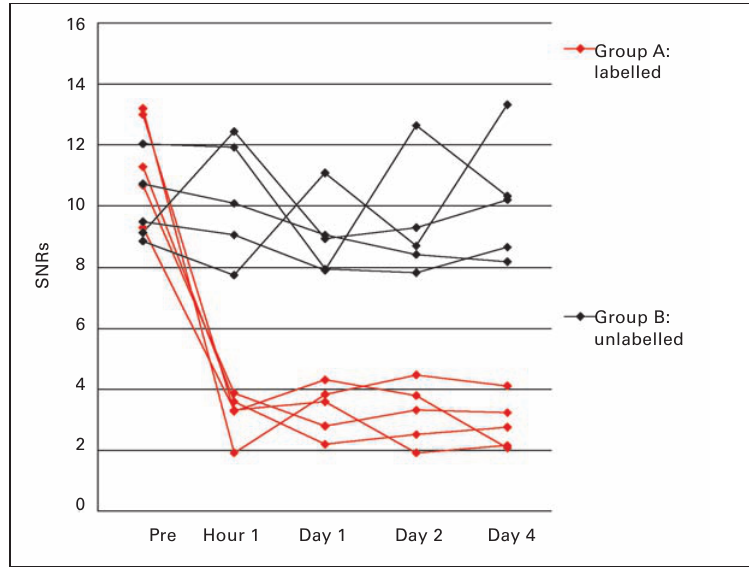
Quantitative measurement of signal-to-noise ratio (SNR)s of outer zone of rats renal cortex on T2*WI at different time points before and after administration of labelled mesenchymal stem cells (MSCs) (group A, red line) and unlabelled MSCs (group B, black line): one line for each rat. In group A, there is significant SNR decrease of renal cortex 1 hour, 1, 2, 4 days after labelled MSCs transplantation, while there is no significant SNR difference among different time points in group B.